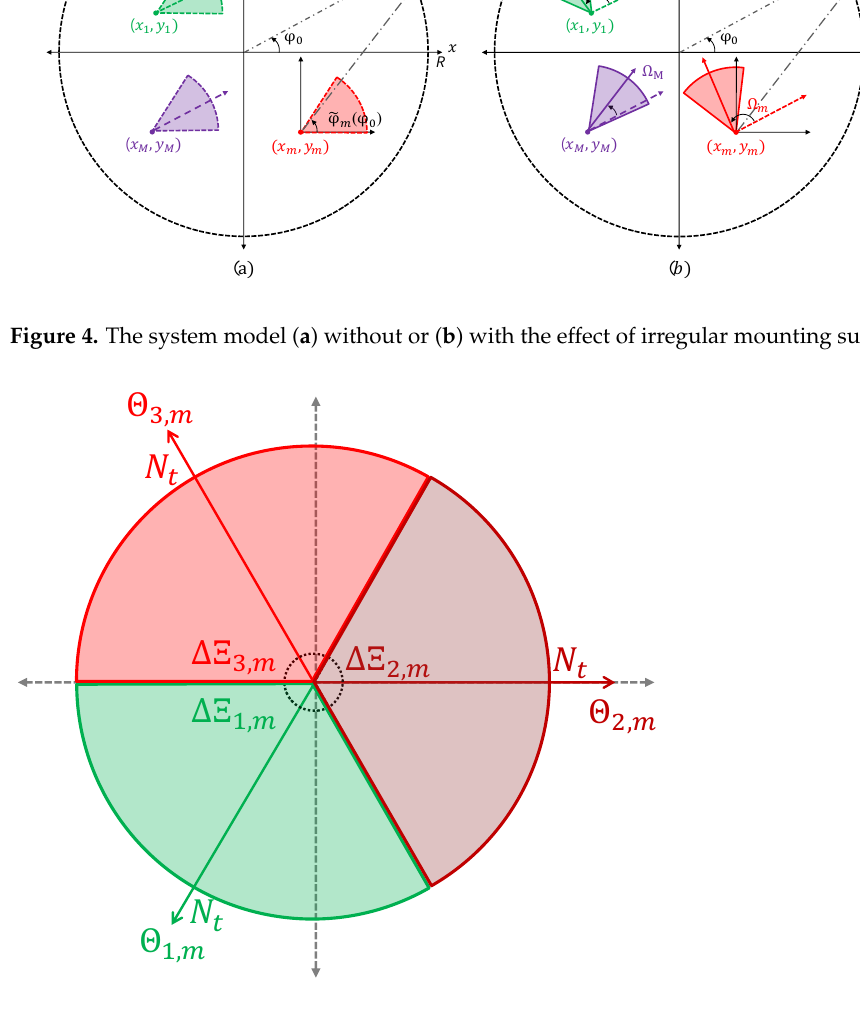
Figure 5. The beampatterns of the BSS with N t = 3 and ∆Ξ i , m = 2 π / N t